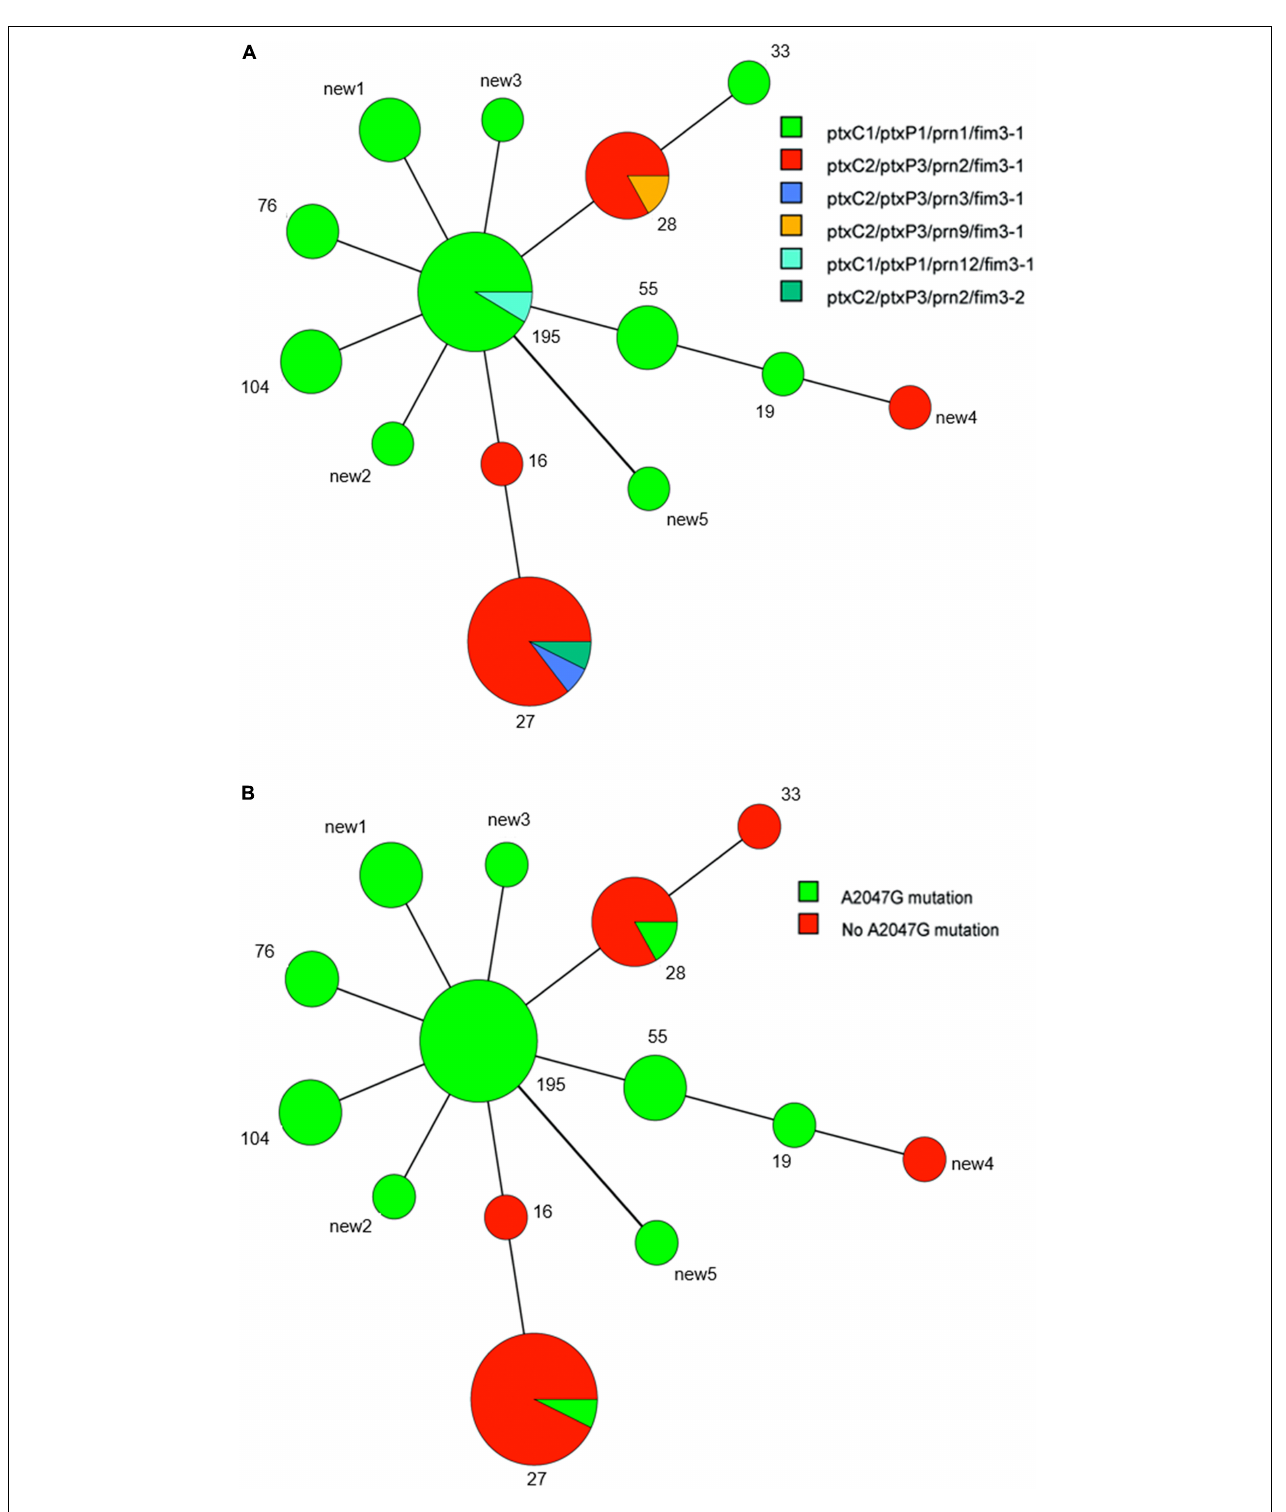
FIGURE 3 | Minimum spanning tree of multi-locus variable-number tandem-repeat analysis (MLVA) types of 50 B. pertussis isolates in the present study. Each circle indicates an MLVA type, and the type number is next to the circle. Circle size indicates the number of isolates categorized according to the particular MLVA type. Differences in the length and thickness of the lines linking two circles indicate differences in the number of VNTRs between the two linked MLVA types. Different colors of circles denote different allelic patterns of virulence antigen genes and different erythromycin susceptibilities. (A) Allelic patterns. (B) Presence or absence of the A2047G